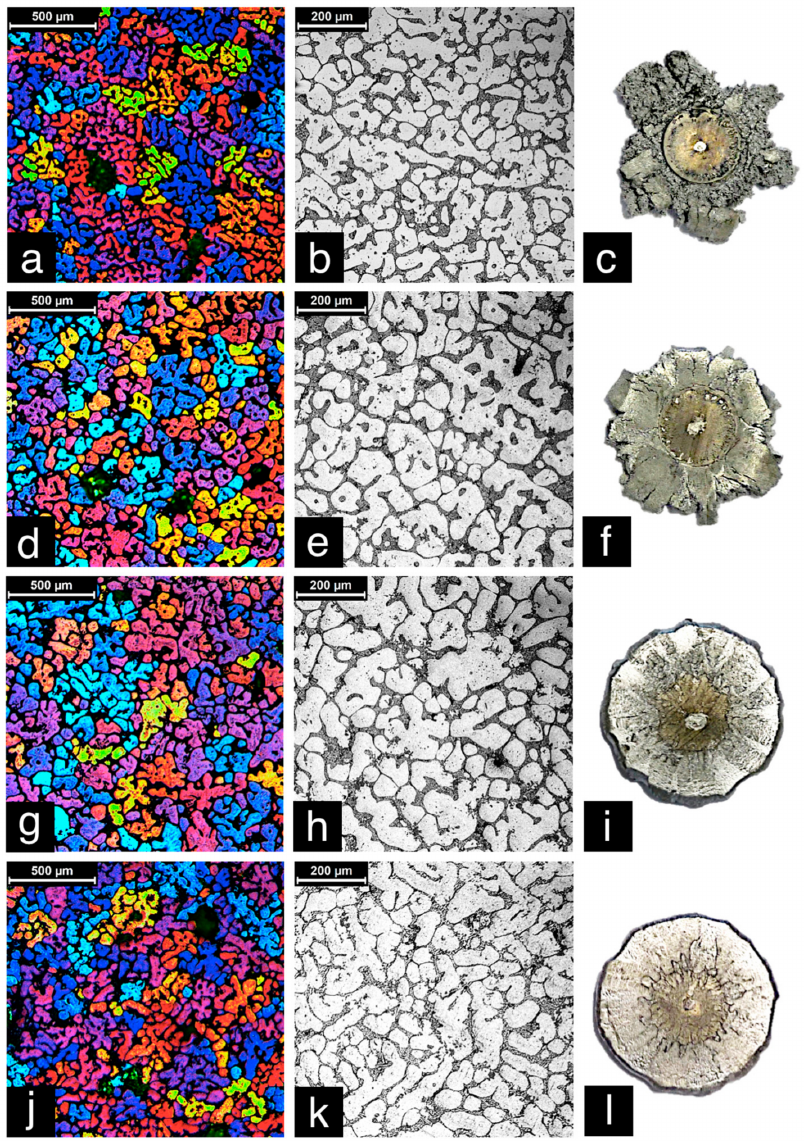
Figure 9. Micrographs showing the microstructure of semisolid B319+Fe alloy (grains—color; globules—B&W) heat-treated isothermally for 60 s at 575 ◦ C ( a , b ), 582 ◦ C ( d , e ), 591 ◦ C ( g , h ), and 595 ◦ C ( j , k ), and the respective thixoformed disks ( c , f , i , l